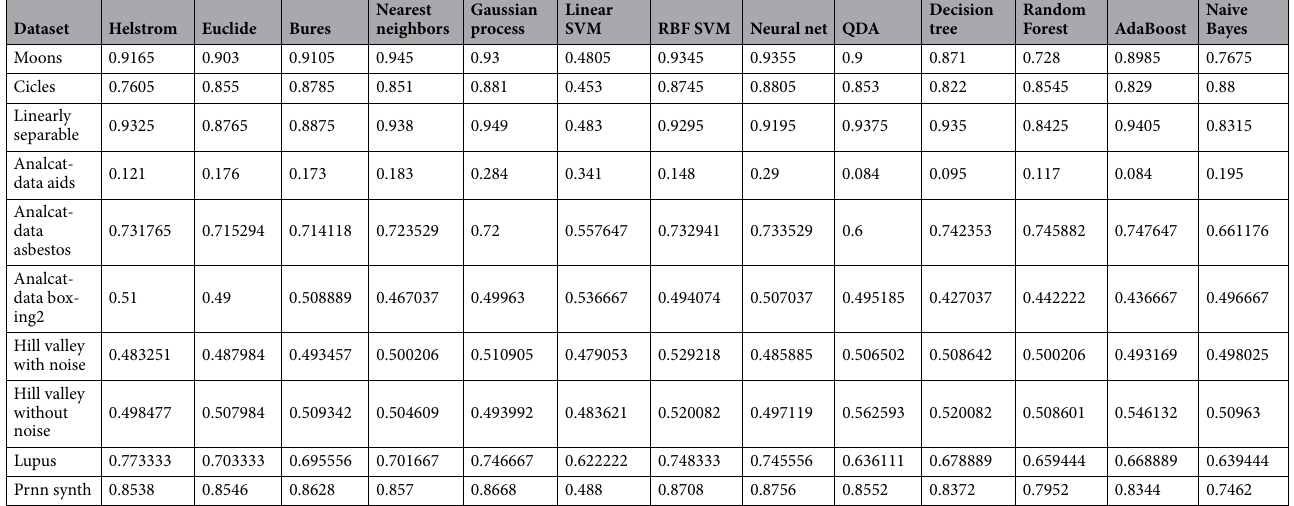
Table 5. Average accuracy with 2 features mapped into high-dimensional feature space ℝ 81 .